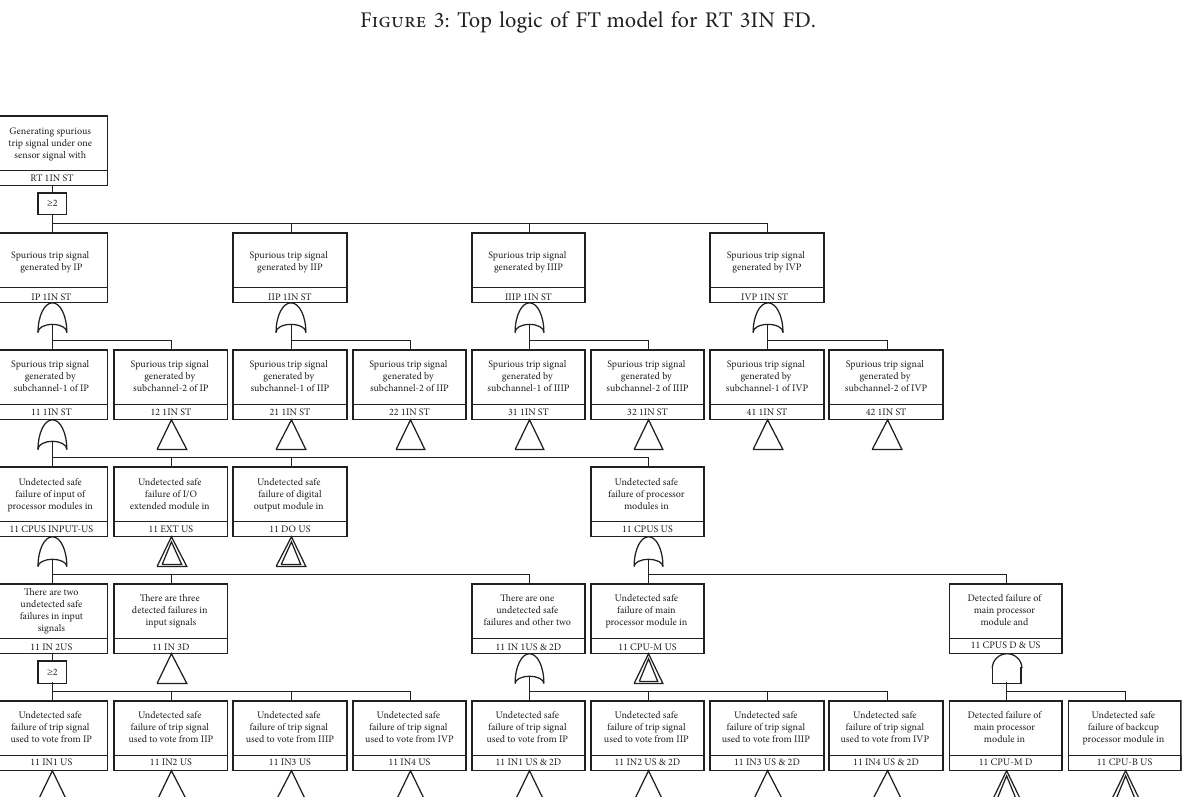
Figure 4: Top logic of FT model for RT 1IN